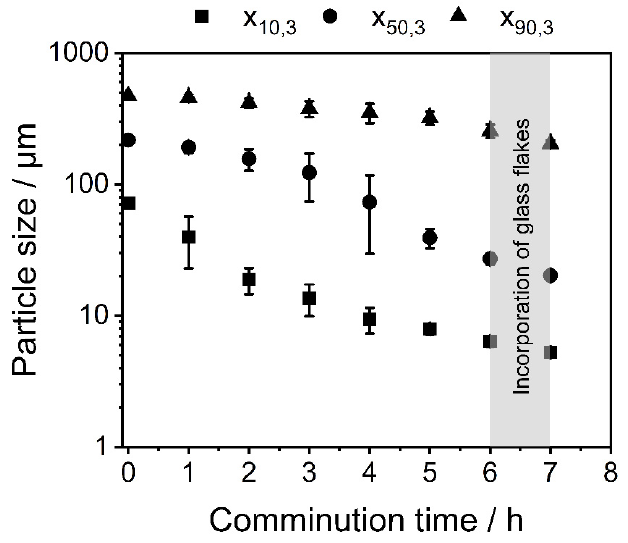
Figure 7. Change in x 10,3 , x 50,3 and x 90,3 during co ‐ comminution and formation of the PBT ‐ PC ‐ glass composite.